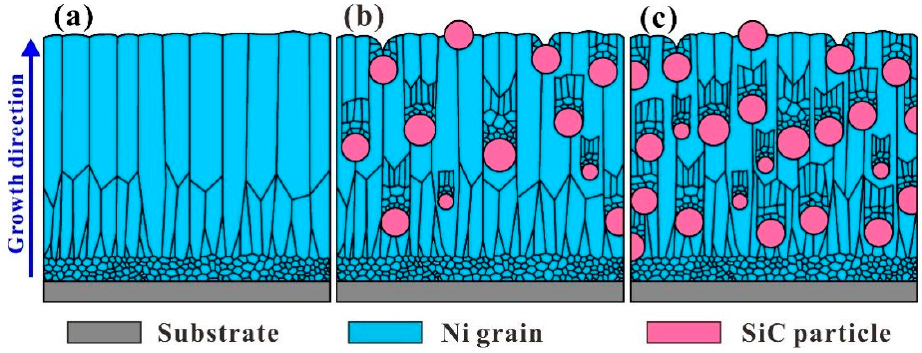
Figure 7. Schematic diagrams of the coating microstructure: ( a ) pure Ni coating; Ni-SiC composite coating contains low content ( b ) and high content ( c ) of SiC